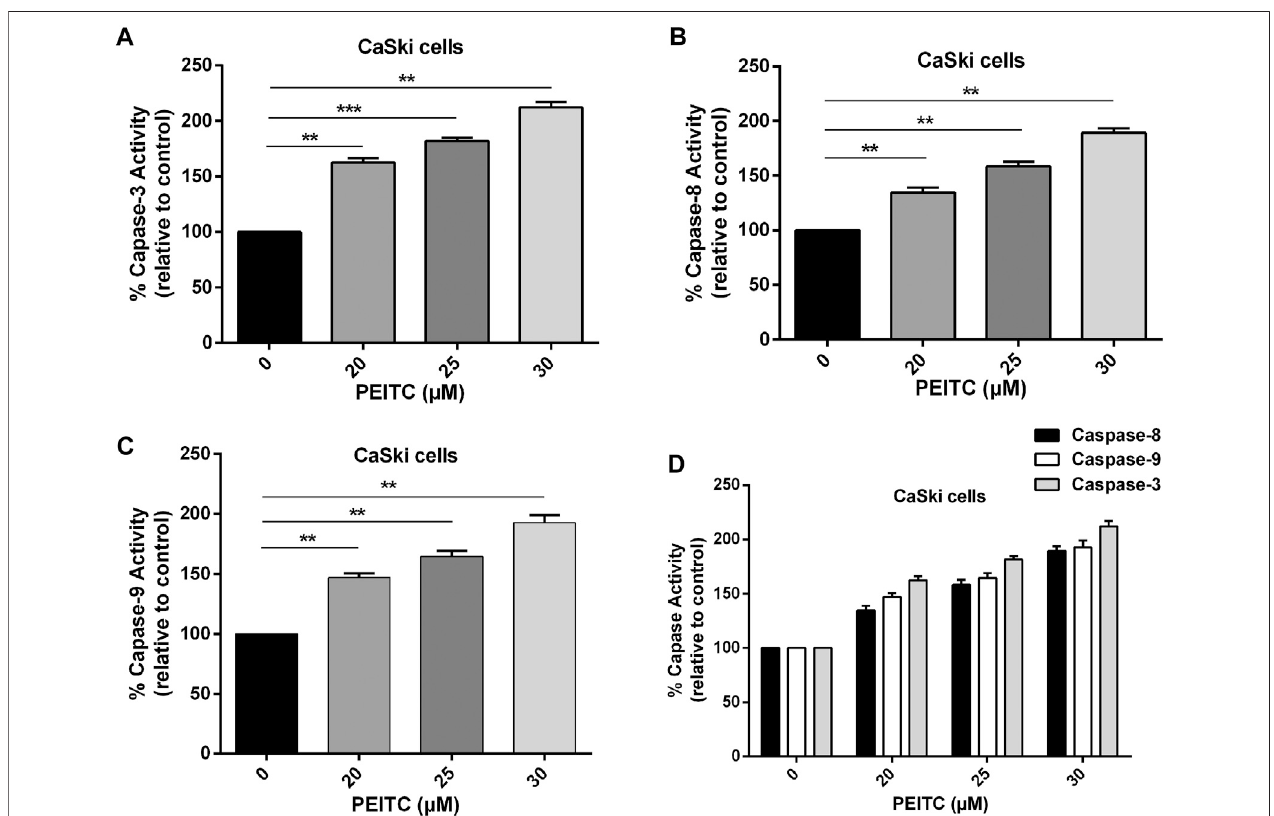
FIGURE4| EffectofPEITConapoptosisinductionasassessedbycaspase-3,-8and-9activityassays. (A-C) PEITC-treatment(20,25and30 μ M)resultedininductionof apoptosis in CaSki cells through activation of caspase-3, -8 and -9 after 24 h. (D) Combined graph exhibiting activation of various cellular caspases in cervical cancer cells after PEITC-treatment.Thedatarepresentsmean ± SDofthreeindependentexperiments.* p value < 0.05comparedwiththeuntreatedcontrolwasconsideredstatisticallysigni fi cant.